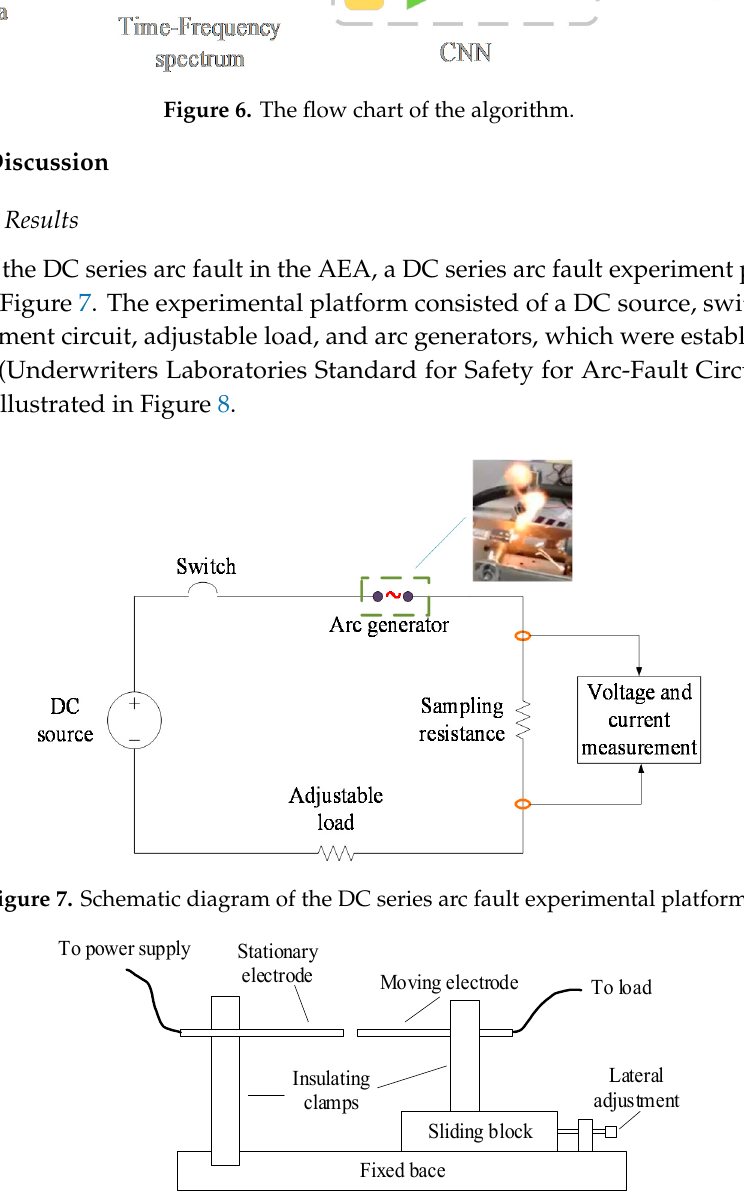
Figure 8. The structure diagram of the arc generator.